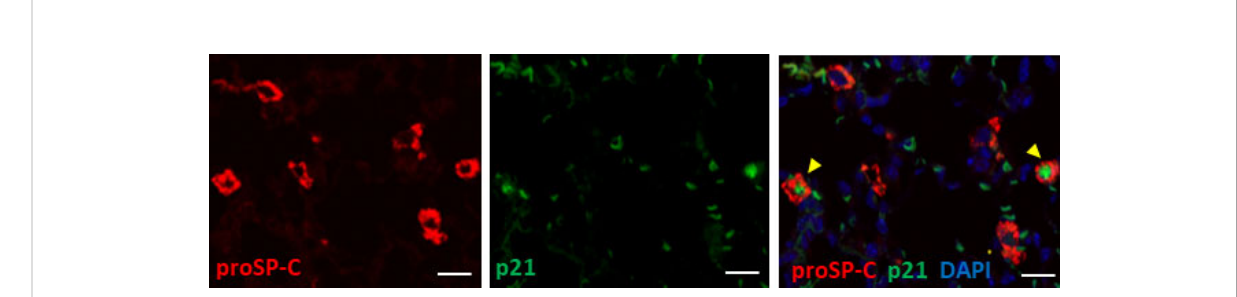
FIGURE 2 Type 2 alveolar epithelial cells (AEC2) undergo senescence in BLM-ILD.Paraf fi n-embedded lung tissue sections from mice 14 days after the instillation of BLM were used for double immuno fl uorescence staining for prosurfactant protein C (proSP-C) (red) and p21WAF1/CIP1 (p21) (green) with 4,6-diamidino-2-phenylindole (DAPI) (blue) counterstaining for nuclei. Yellow arrows indicate double-positive cells. The scale bar indicates 20